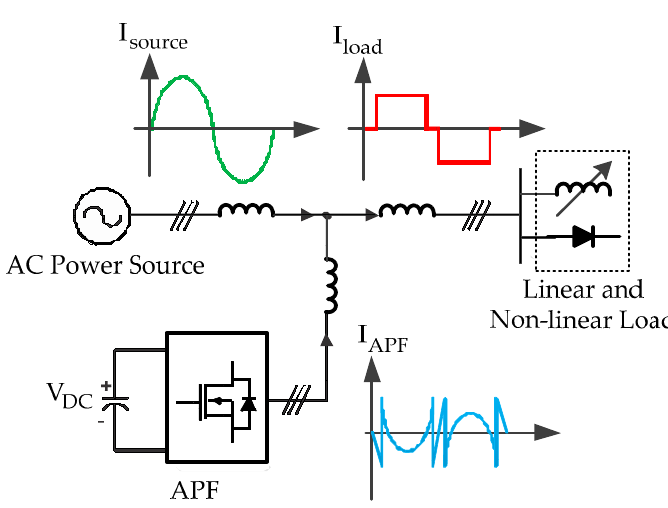
Figure 1. The active power filter (APF) current compensation concept.